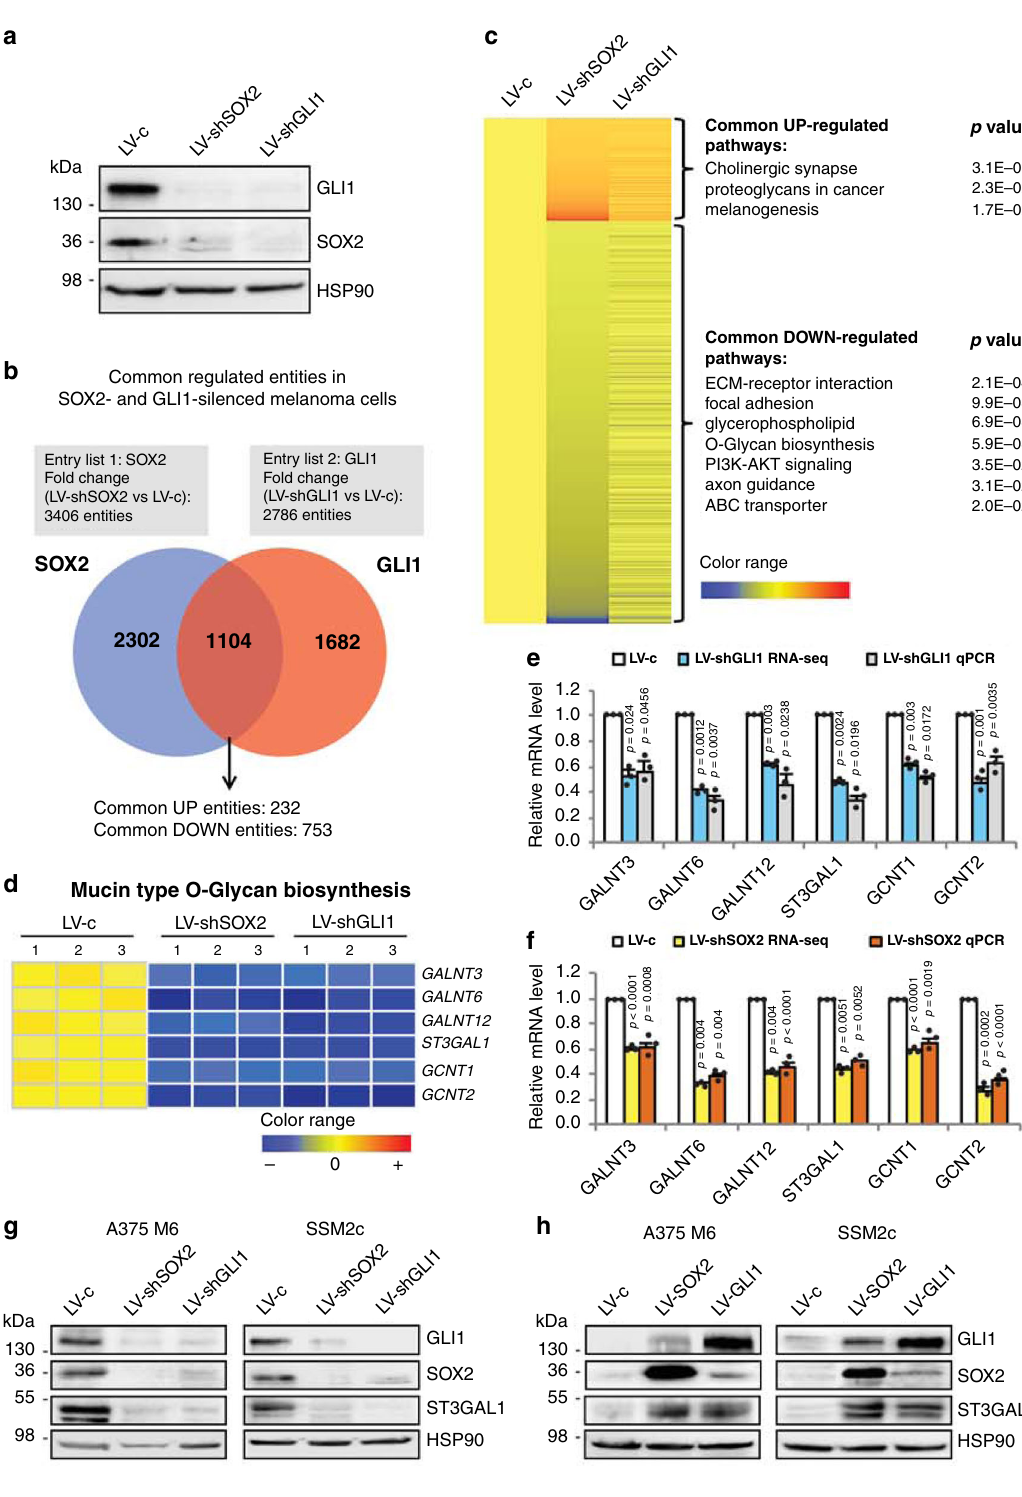
Consistent with these results, ectopic expression of ST3GAL1 in the metastatic cell line MeWo and in patient-derived metastatic cells M51 (Fig. 3f), both of which express low levels of ST3GAL1 (Fig. 2f), accelerated wound closure and enhanced invasion in vitro (Fig. 3g – j), with concomitant increased expression of EMT markers (Fig. 3f). Modulation of ST3GAL1 expression had no signi fi cant effect on melanoma cell growth, although ST3GAL1 overexpression slightly decreased the fraction of early apoptotic cells only in MeWo cells, without affecting